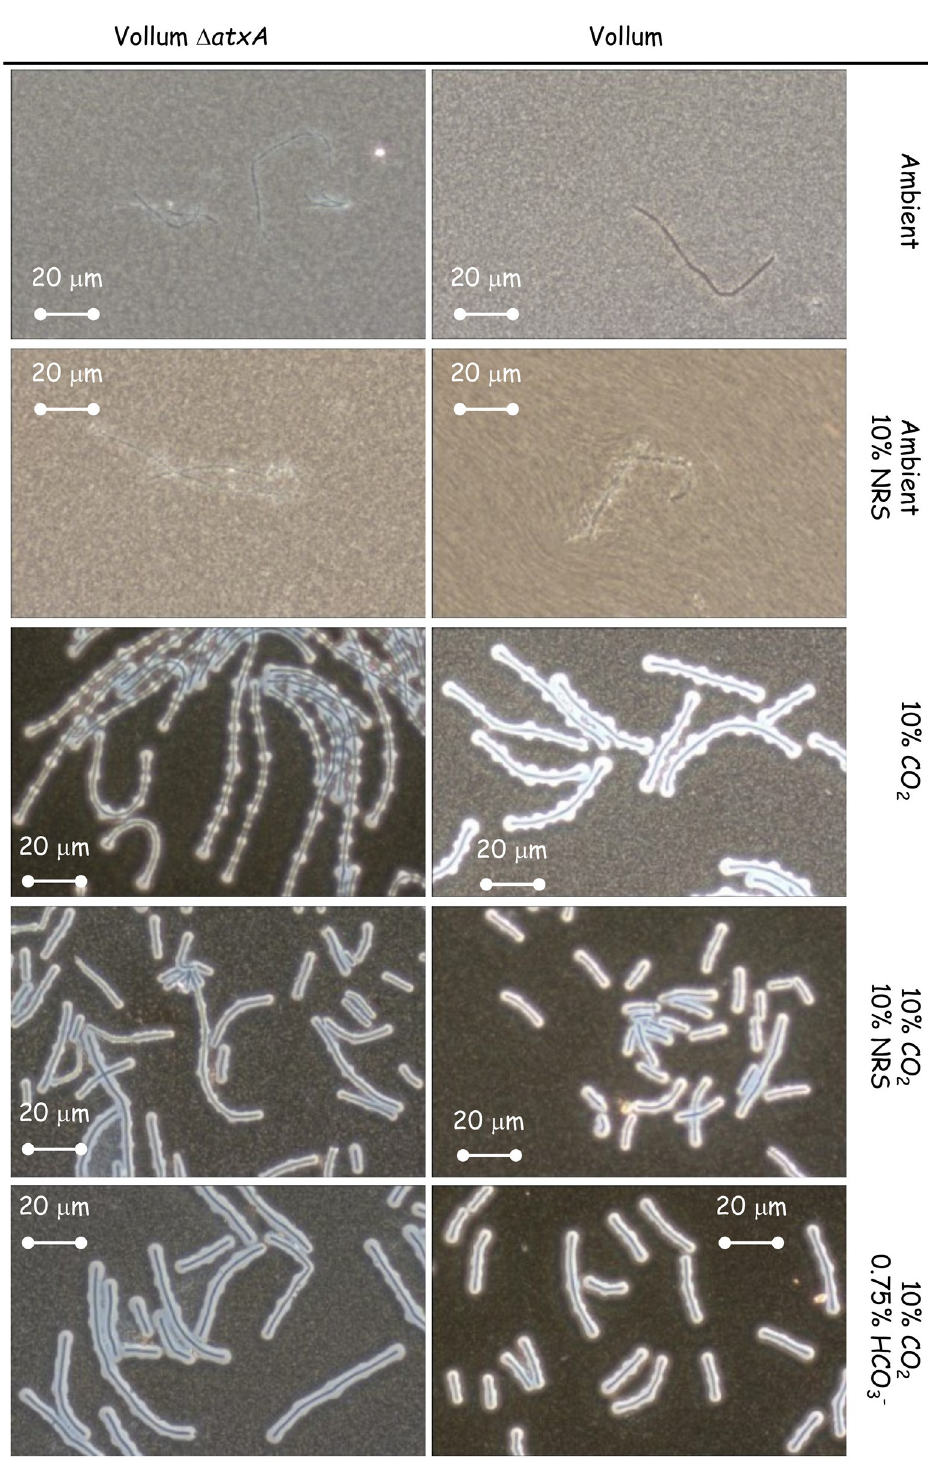
Fig 3. Effect of deleting atxA on capsule production after a short (5h) incubation under different growth conditions. Spores of the wild type and Δ atxA mutant (top panel) were seeded into 100 μ l of sDMEM as is or supplemented with 10% NRS and incubated at 37˚C in an ambient or 10% CO 2 atmosphere (as indicated on the right) for 24h. Capsule was imaged by India ink negative staining (capsule presence forms a typical bright outer layer).